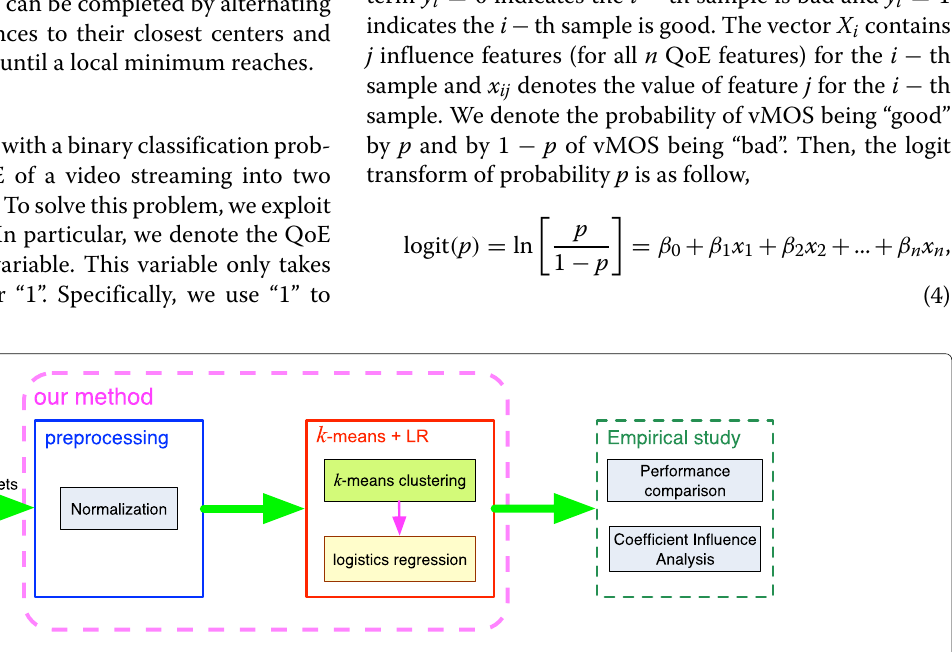
The goal of K -means is to minimize the within-cluster sum of variance over all clusters. In other words, we need to find